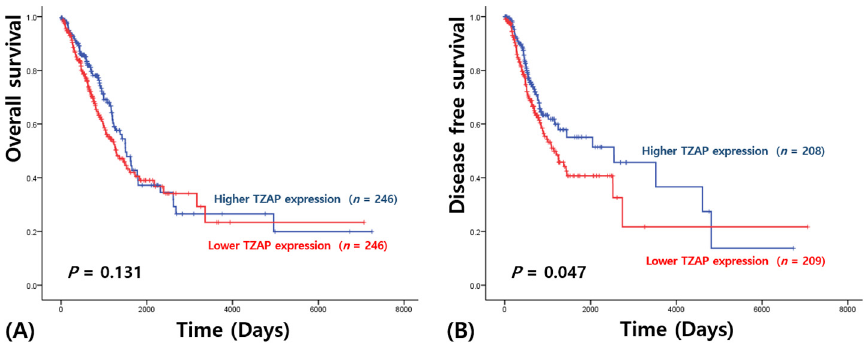
Figure 2. Survival analysis in adenocarcinoma: ( A ) overall survival; ( B ) disease-free survival. In SCC, TZAP expression did not have any prognostic values of OS (2215.91 ± 174.72 vs. 1946.47 ± 148.77 days, p = 0.805; Figure 3A) and DFS (2614.32 ± 215.95 vs. 2812.18 ±